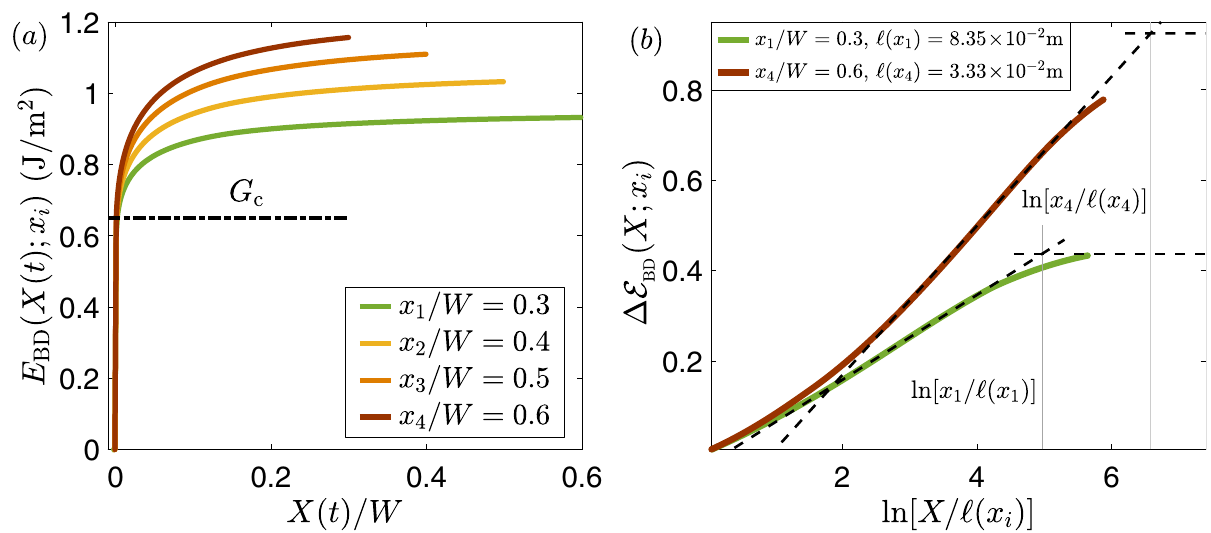
(see text for de fi nition), i